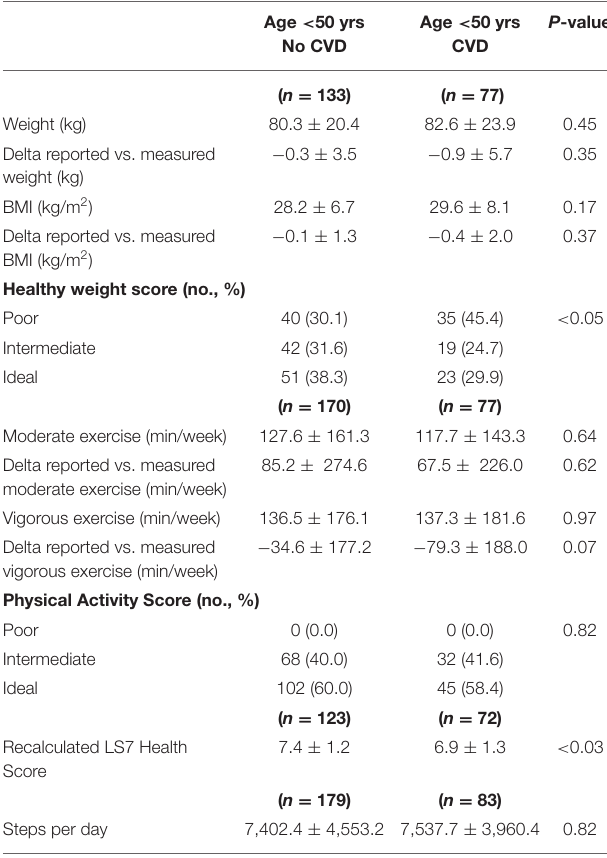
TABLE 3 | Digital health device measured weight and exercise data for participants age < 50 yrs with or without